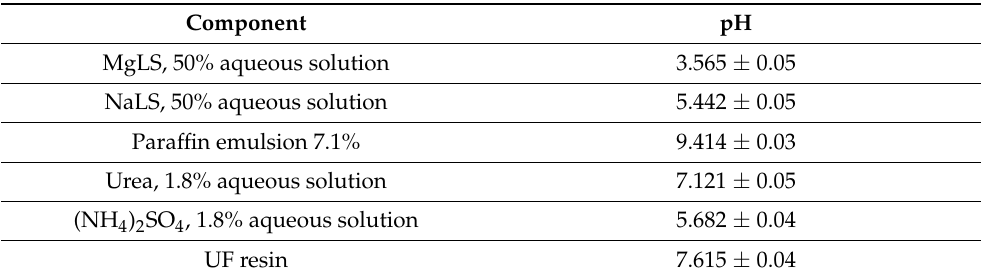
Table 3. pH values of the individual components of the adhesive compositions.